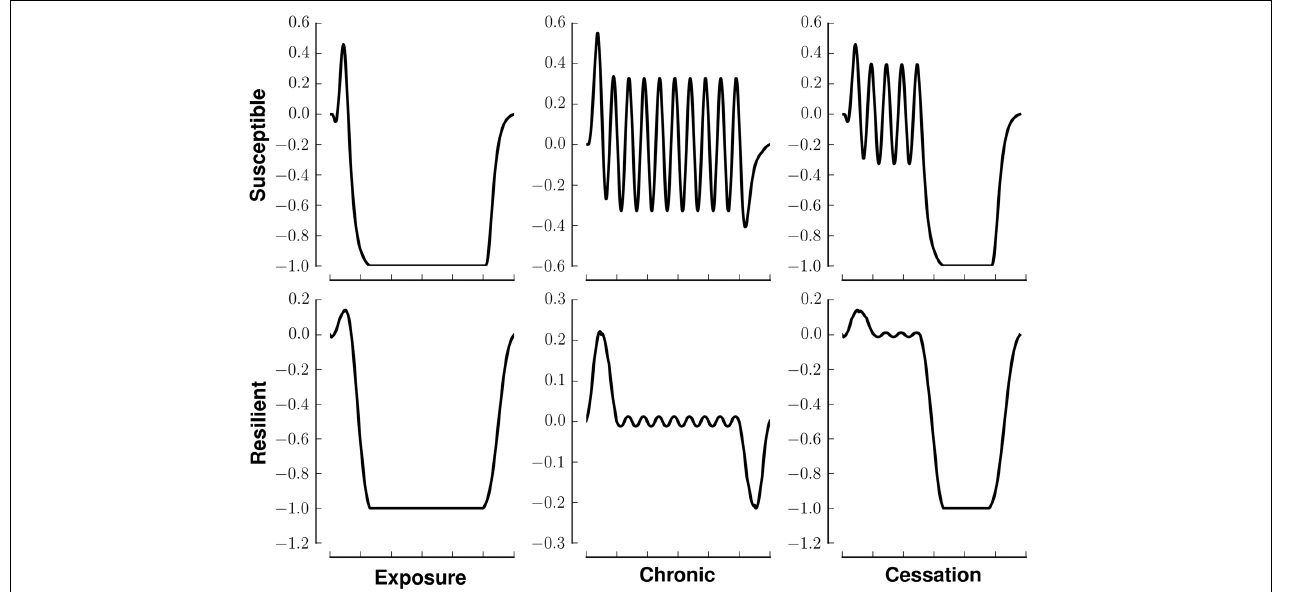
FIGURE 2 | Stimuli-reward patterns for simulation. Each panel shows the reward in arbitrary units over time associated with different patterns of drug use. Rows denote different network modes, susceptible or